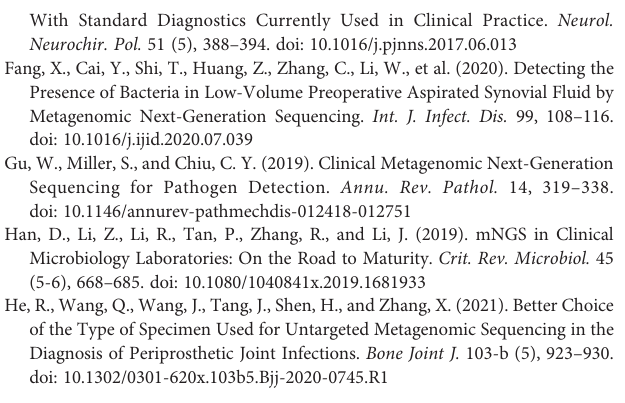
Supplementary Figure 1 | Univariable meta-regression. Supplementary Figure 2 | The Deeks ’ funnel plot of the pooled DOR. DOR, diagnostic odds ratio; ESS, effective sample size. Supplementary Figure 3 | Summary of positive likelihood ratio and negative likelihood ratio for the diagnosis of PJI. LLQ, left lower quadrant; LRN, likelihood ratio negative; LRP, likelihood ratio positive; LUQ, left upper quadrant; RLQ, right lower quadrant; RUQ, right upper quadrant. Supplementary Figure4 | FagannomogramofthemNGSforthediagnosisofPJI.